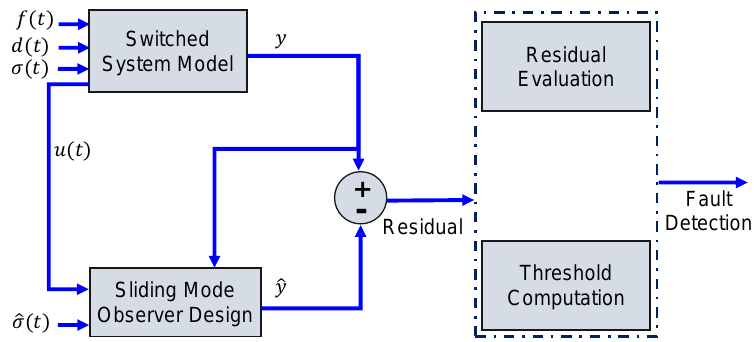
Figure 1. Design scheme of fault